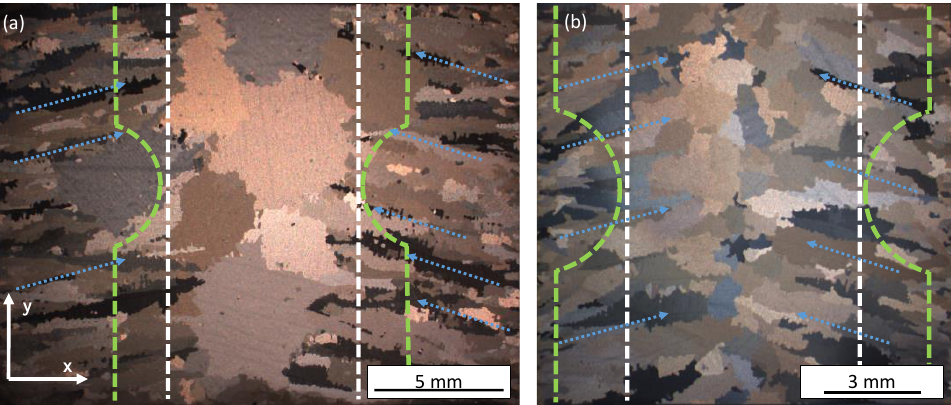
Figure 1. Longitudinal cut of the 20 mm bar ( a ) and 12 mm bar ( b ).